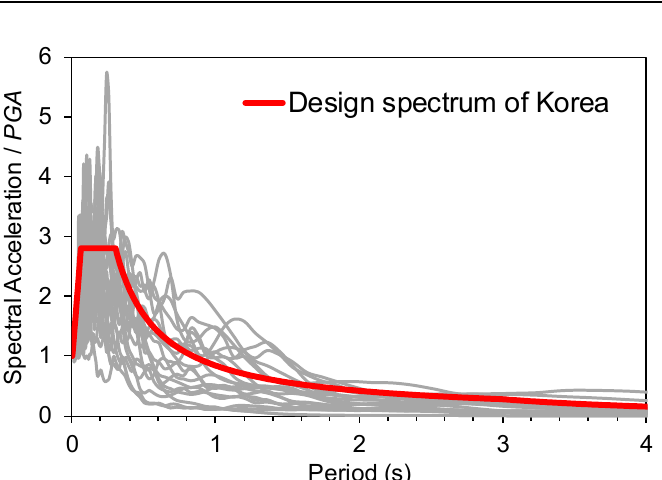
Figure 5. Spectrum of 5% damped response of input motions and the design response spectrum of Korea [19] normalized to the PGA .